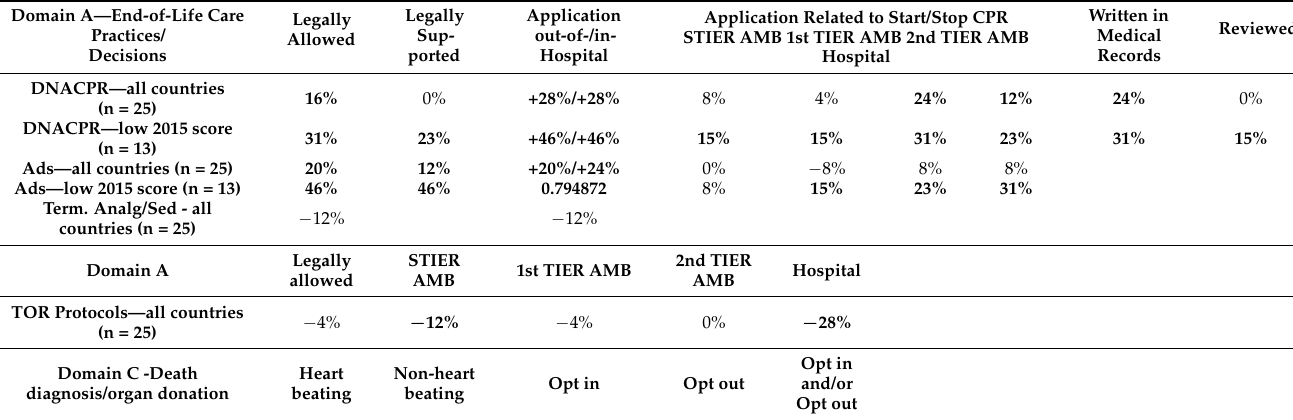
Table 2. Main proportional (%) changes in positive responses to variable-specific questions from 2015 to 2019.